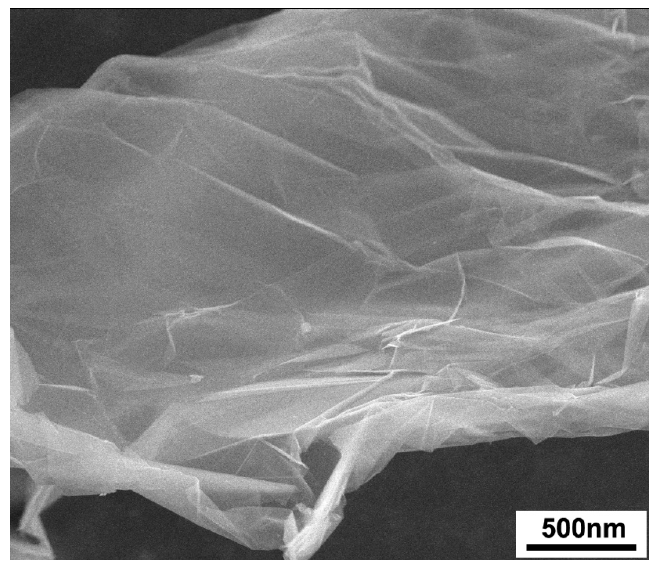
Figure 1. SEM image of single-layer graphene with an average diameter of 2 μ m.